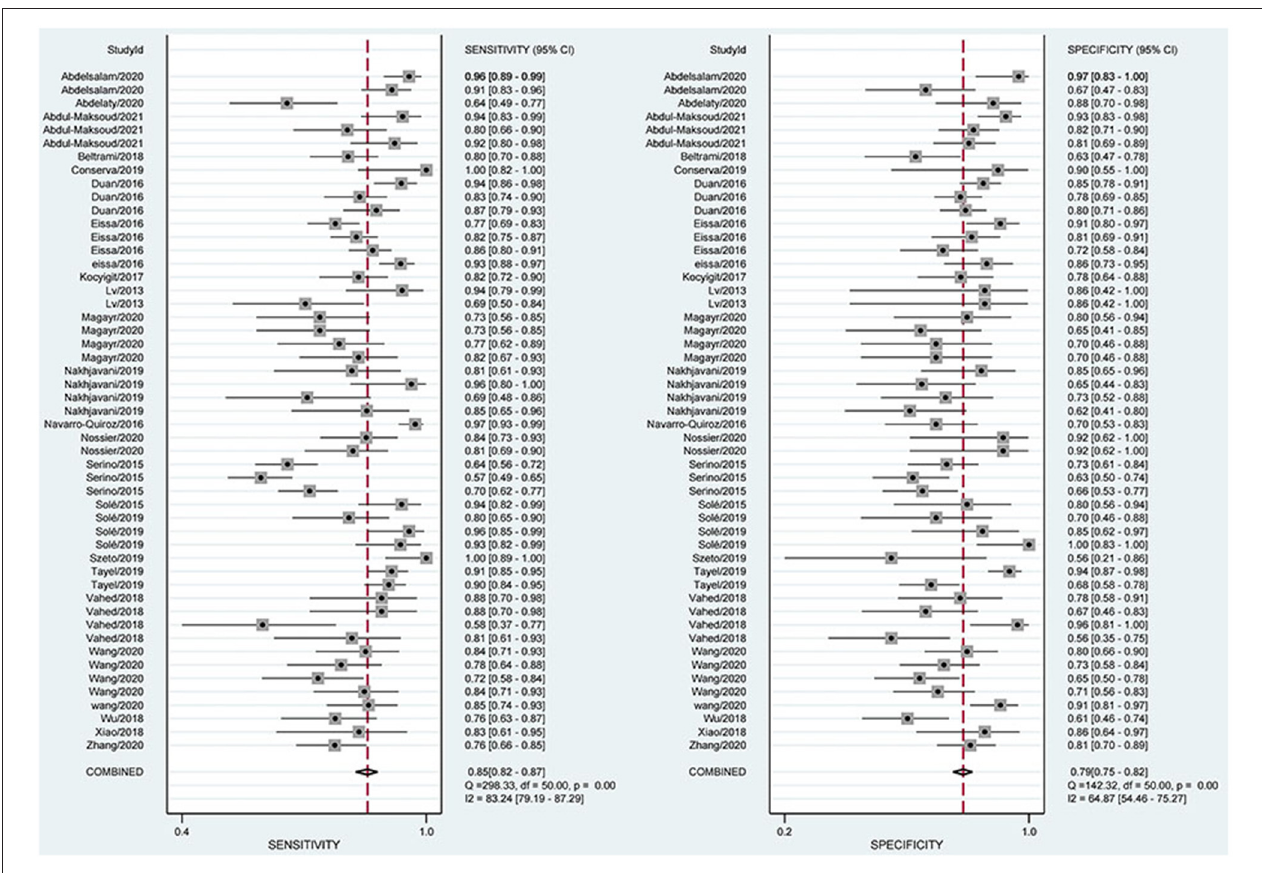
FIGURE 6 | Sensitivity and specificity after